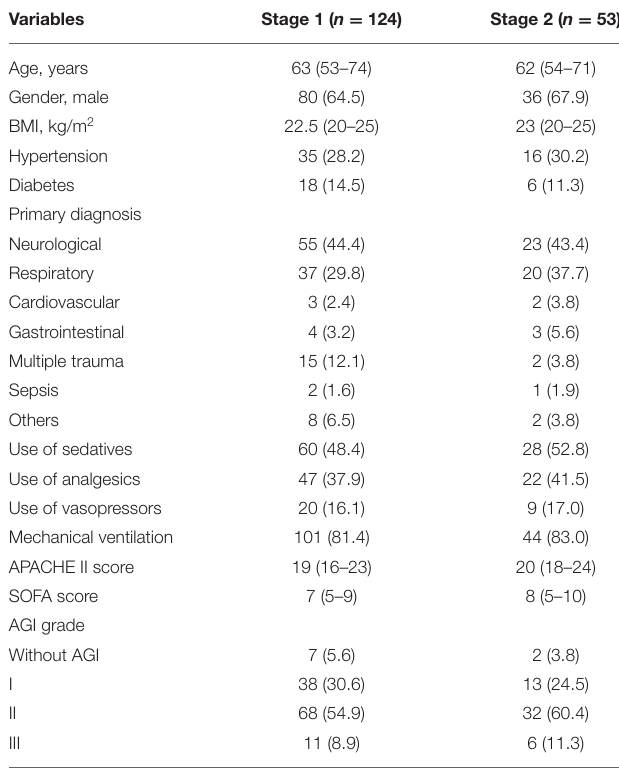
TABLE 1 | Patient demographics and baseline clinical